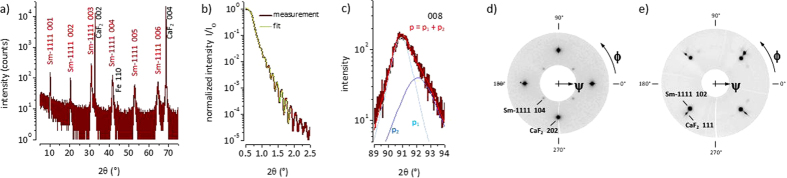
(a) High resolution XRD (2θ/ω-scan) of SmO1−xFx FeAs/CaF2. 00l reflections of the 1111 phase and the substrate are indexed. The obtained lattice parameter is c1111 = 8.66 Å. Small amount of Fe impurity is found as indicated by the Fe 110 reflection. (b) A total film thickness of 58.4 nm was evaluated from a fit of the normalized XRR intensity in the range of 2θ = 0.6°–1.8°. (c) 008 Bragg reflection with total maximum at 2θ ≈ 90.95° as a superposition of two extremal profiles p1 (with maximum at 2θ ≈ 90.9°) and p2 (with maximum at 2θ ≈ 92.1°). (d) Pole figure (ψ, ϕ) for 2θ = 47.0° ± 1.0° with CaF2 202 and SmO1−xFxFeAs 104 reflections. (e) Pole figure (ψ, ϕ) for 2θ = 30.0° ± 1.2° with CaF2 111 and SmO1−xFxFeAs 102 reflections.